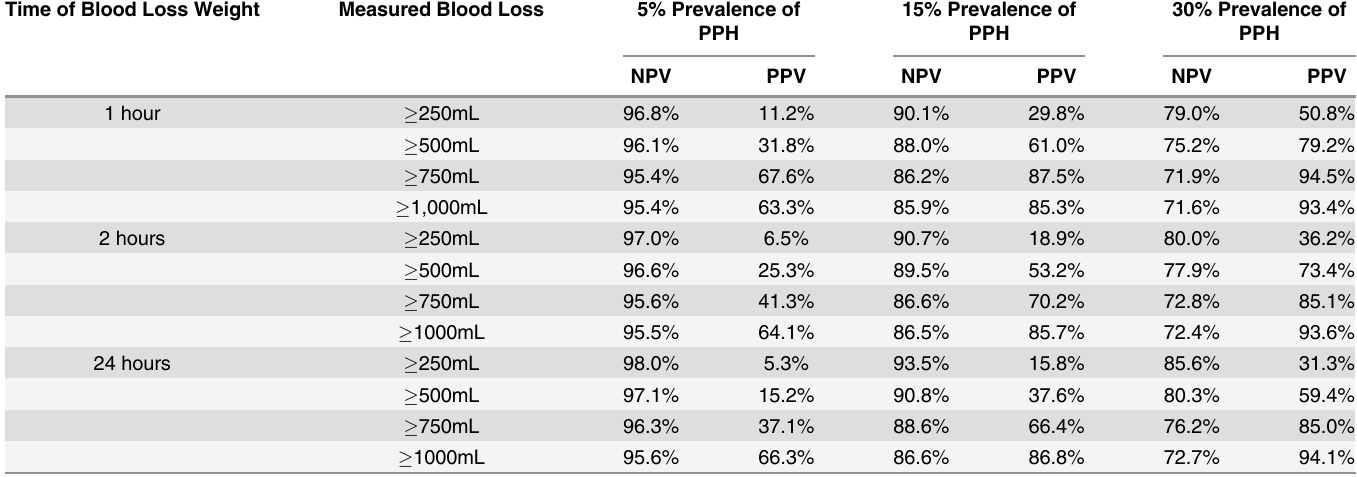
Table 4. Negative and positive predictive values of blood loss measurement by weight method versus a reference standard of > 10% drop in haemoglobin. Time of Blood Loss